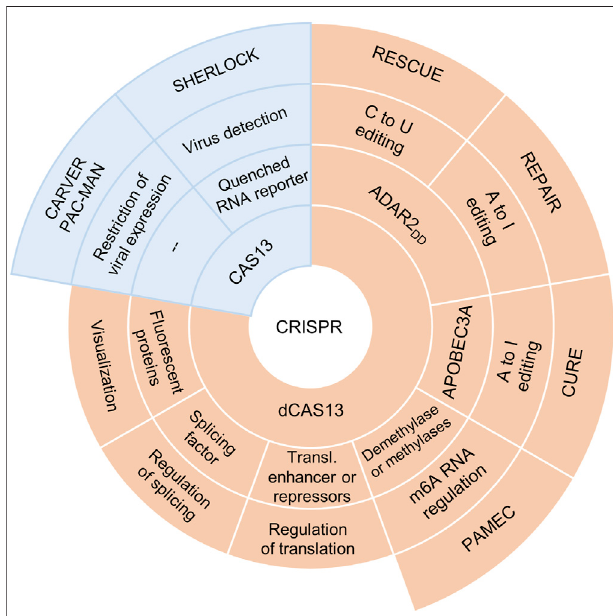
FIGURE 1 | A brief overview of Cas13-based applications. For the detectionofviralgenomes invitro ,CRISPR – Cas13a isused aspart ofspeci fi c high-sensitivity enzymatic reporter UnLOCKing (SHERLOCK), where CRISPR – Cas13a cleaves a target RNA in the presence of a quenched RNA reporter that emits its fl uorescence signal (Gootenberg et al., 2018). CRISPR – Cas13 isalsoacomponentoftheCARVER system (Cas13-assisted restriction of viral expression and readout), which is aimed at speci fi c degradation of viral RNA in vivo and has been successfully applied to various viral RNAs in cultured cells (Freije et al., 2019). Moreover, CRISPR – Cas13d within the PAC-MAN (prophylactic antiviral CRISPR in human cells) system inhibits SARS-CoV-2 replication by directly targeting and cleaving all viral positive-sense RNA (Abbott et al., 2020). The fusion of CRISPR – dCas13 with fl orescentproteinshelpedtousethissystemforRNAimagingandresearchon traf fi ckingofRNAs(Abudayyehetal.,2016);fusionwithasplicingfactorallows for regulation of alternative pre-mRNA splicing (Wang et al., 2019b), whereas fusion with a translational enhancer or repressor can help to manage the translation of a speci fi c mRNA (Abudayyeh et al., 2016). Some investigators (Zhao et al., 2020) devised a photoactivatableRNA-m 6 A-editingsystemusing CRISPR – dCas13 (PAMEC), which enables regulation of the methylation level of target RNA sites by means of light of different wavelengths. The fusion of dCas13 with deaminases has laid the foundation for the creation of site- directed RNA base – editing systems CURE, REPAIR, and